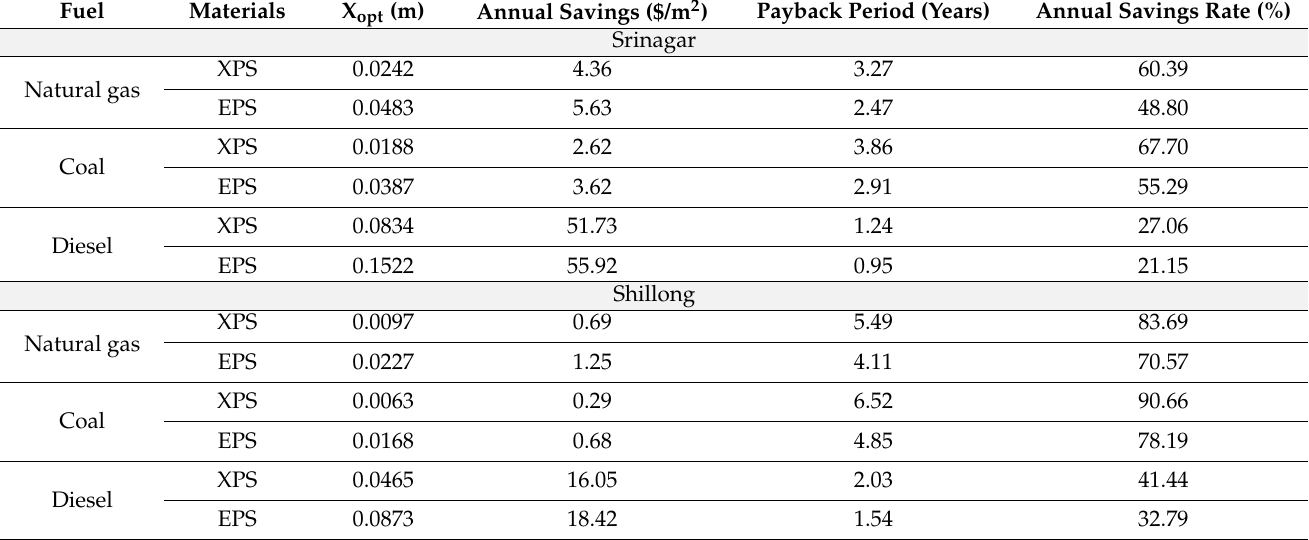
Table 5. Results of various insulation materials for